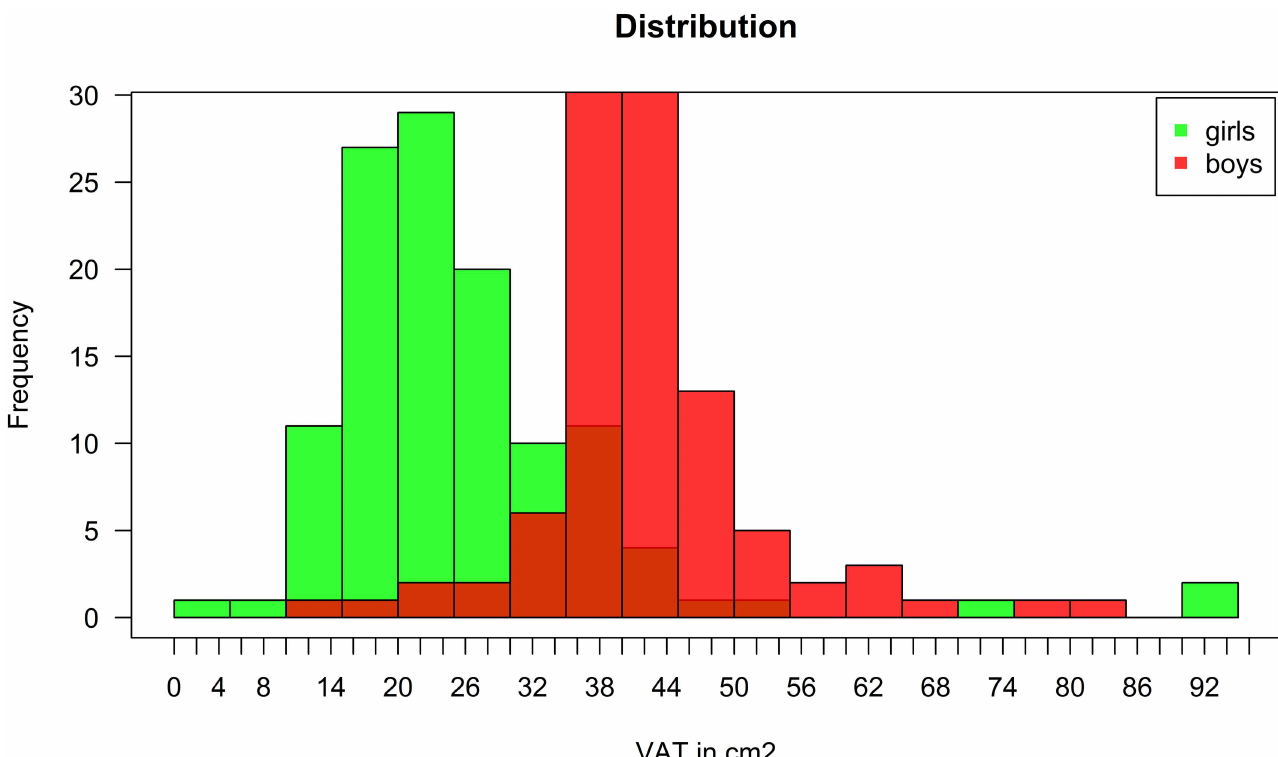
Fig 1. Visceral adipose tissue (VAT) distribution in girls and boys.